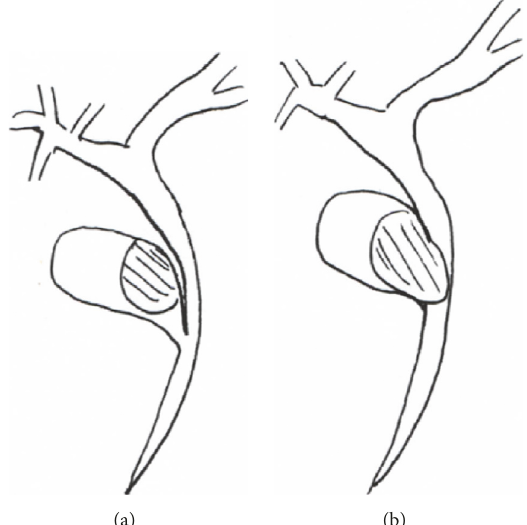
Figure 1: (a) Type I Mirizzi syndrome: a big stone impacted in the gallbladder infundibulum cause jaundice by extrinsic compression of the CBD; (b) type II Mirizzi syndrome: the stone is located in a single cavity formed by gallbladder and